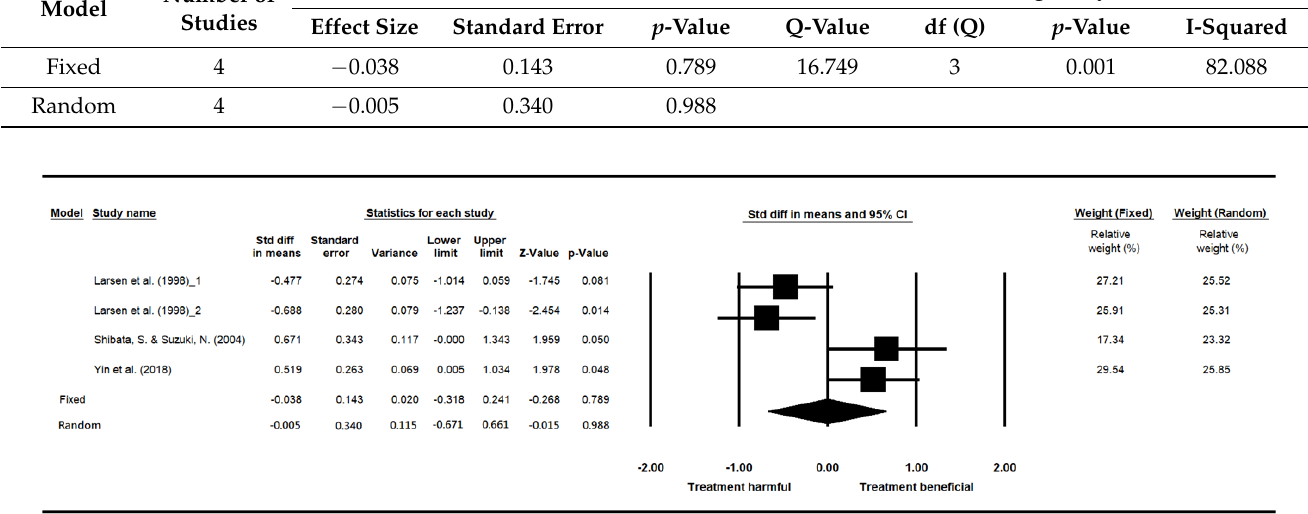
Figure 5. Forest plot of studies on the influence of indoor plants on attention [53,71,75].